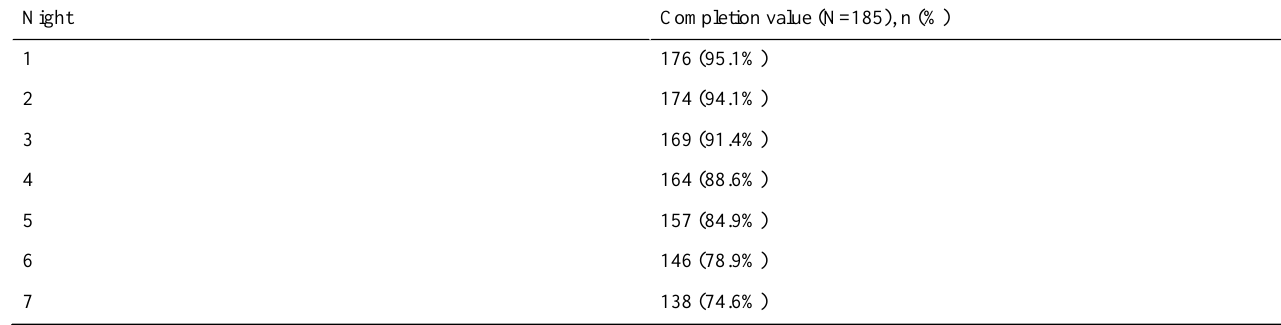
Table 2. Overview of assessment completion each